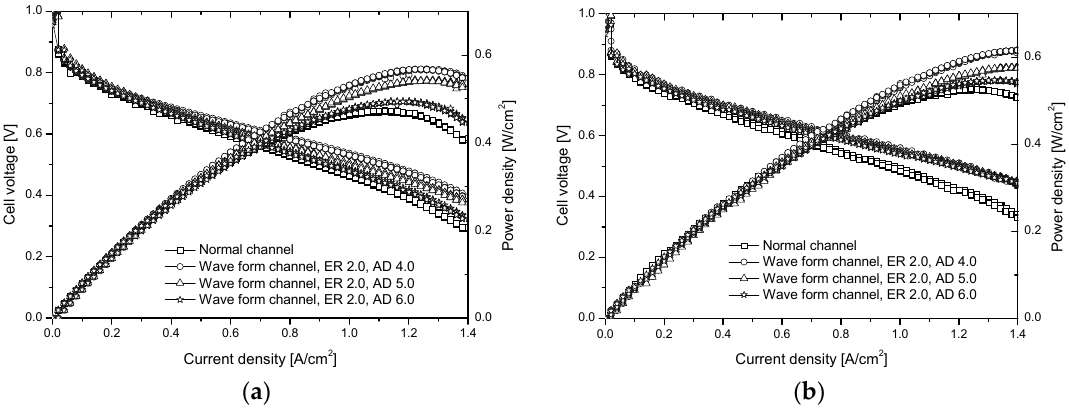
Figure 14. Pressure difference of the normal channel and wave form channel with varied ER, according to variation in the cathode stoichiometry of ( a ) RH 75% and ( b ) RH 90%